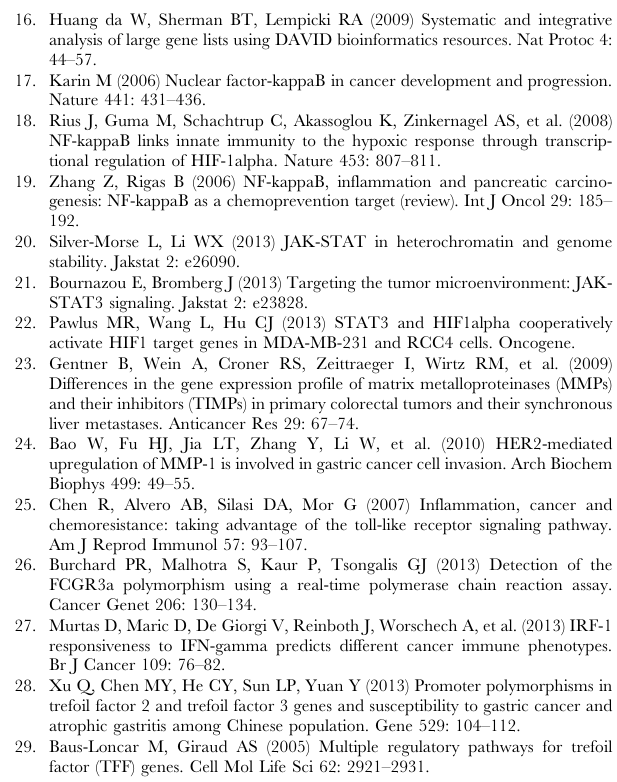
Table S3 Summary of these82 differentially expressed genes in the TF-regulatory network in gastric cancer tissues. Table S4 The 95 regulation modes formed by 82 differential genes in TF-gene regulatory network. All regulation information was derived from transcriptional regulatory element database (TRED).